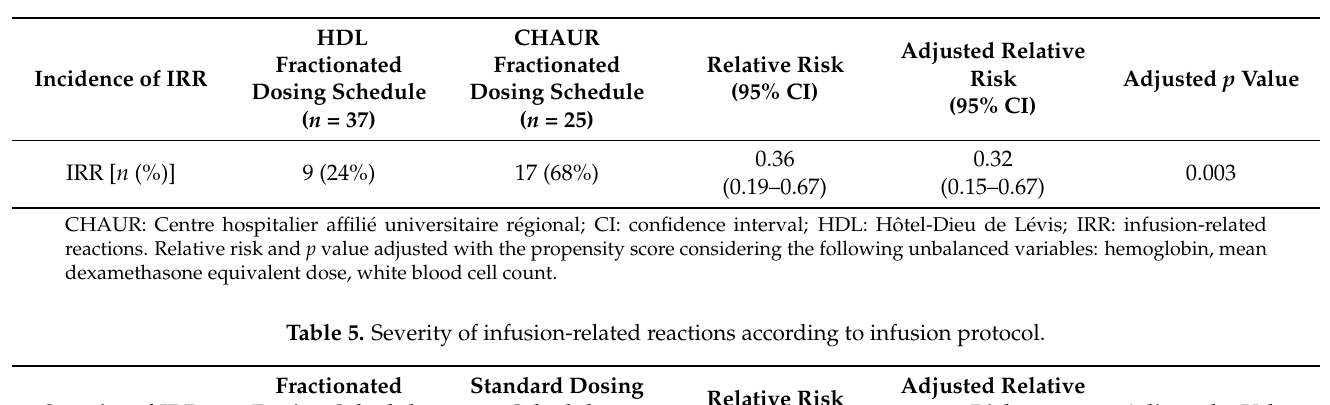
Table 4. Incidence of infusion-related reactions according to the fractionated dosing schedule.